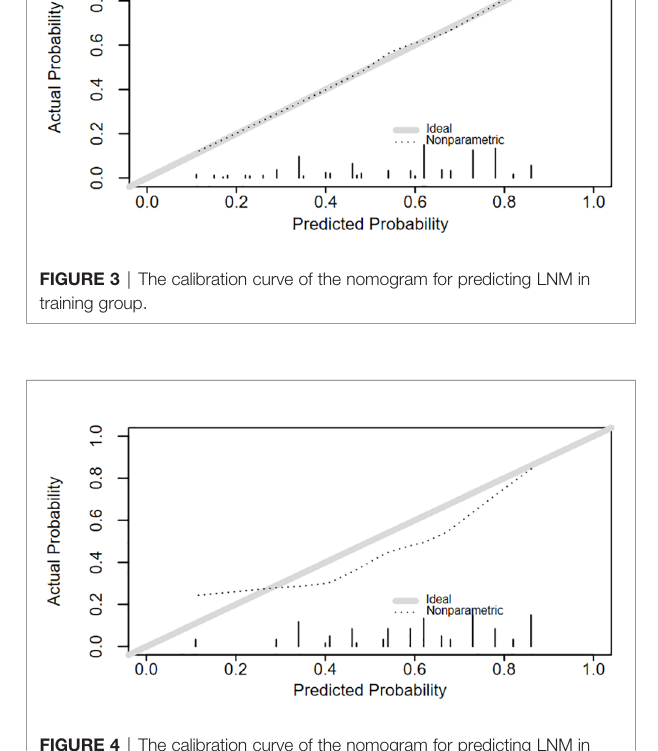
FIGURE 4 | The calibration curve of the nomogram for predicting LNM in test group.